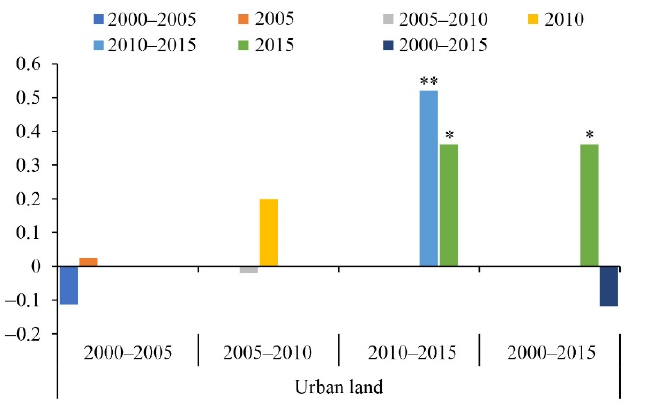
Figure 7. Bivariate correlation between changes in park access and land urbanization (* and ** denote the significance of correlation coefficient estimate at the 0.05 and 0.01 level, respectively).